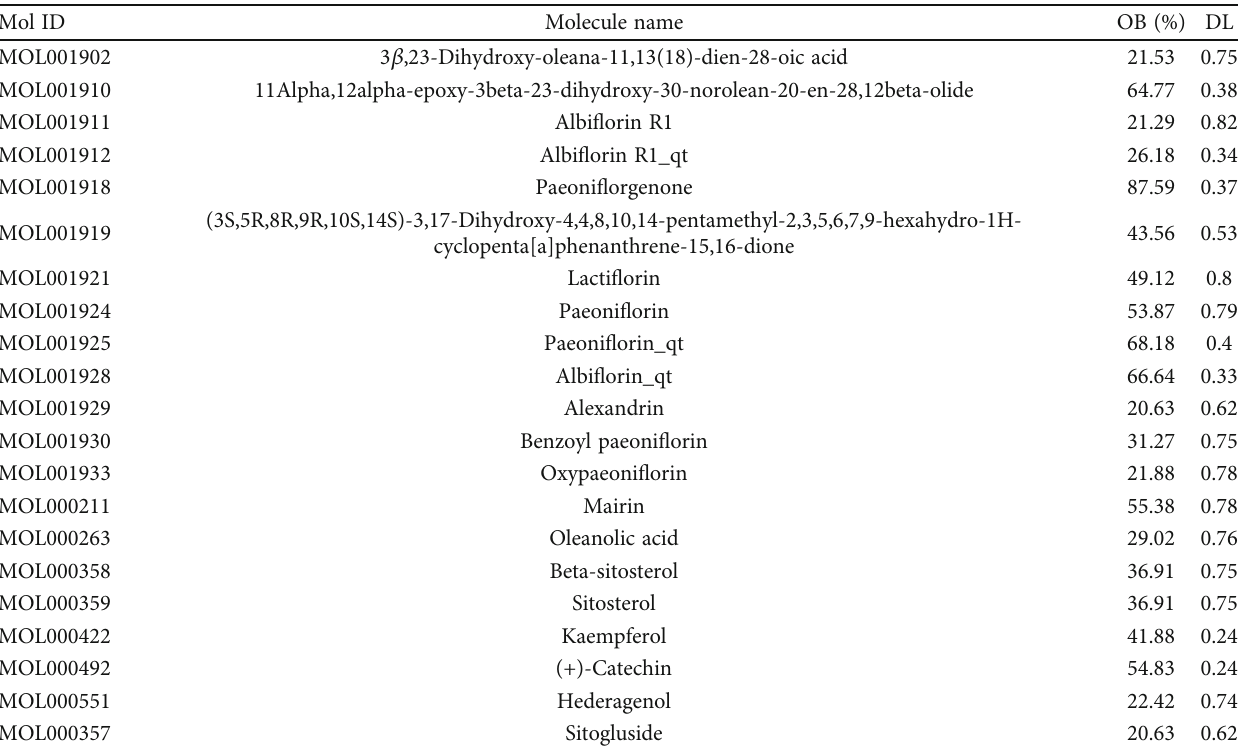
Table 1: Candidate active ingredients of